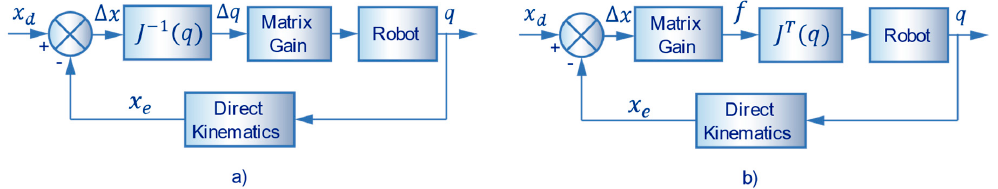
Figure 2. Block schemes of operational space control ( a ) with Jacobian inverse and ( b ) with Jacobian transpose.